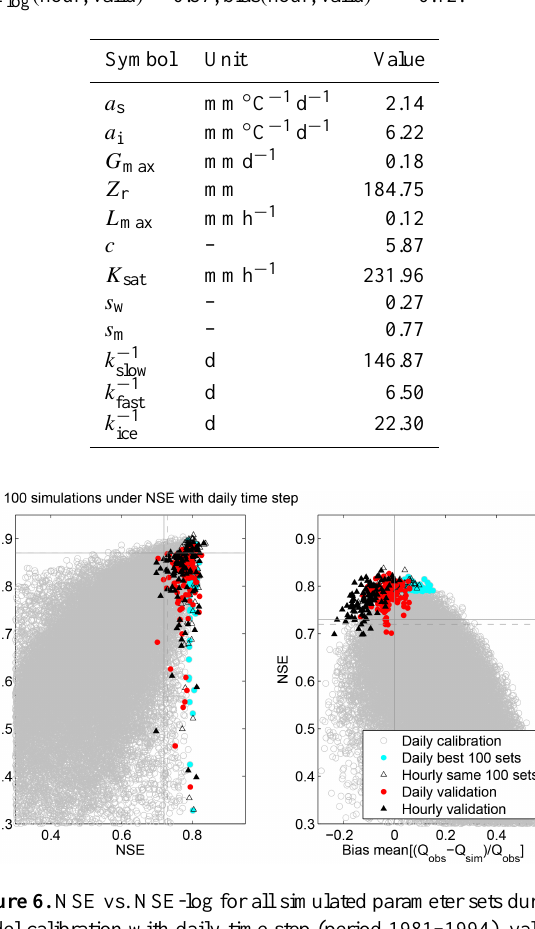
Table 3. The calibrated parameter values corresponding to the parameter set with the best NSE value at the daily time step for the calibration period. The performance criteria values of this set are: NSE ( day, calib ) = 0.82, NSE log ( day, calib ) = 0.85, bias ( day, calib ) = − 0.03, NSE ( day, valid ) = 0.76, NSE log ( day,